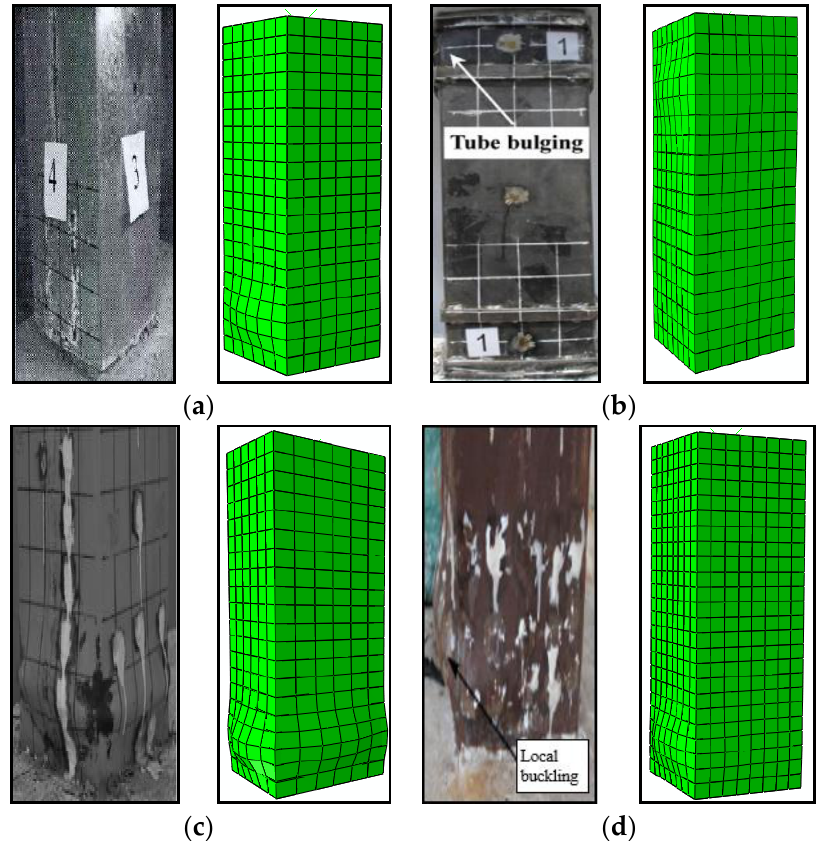
Figure 9. Comparison of failure modes between test specimens and FE models under cyclic loading under ambient temperature. ( a ) STRC-60-1.5-4; ( b ) STRC-70-1.5-4; ( c ) FGZ4; ( d ) A1.